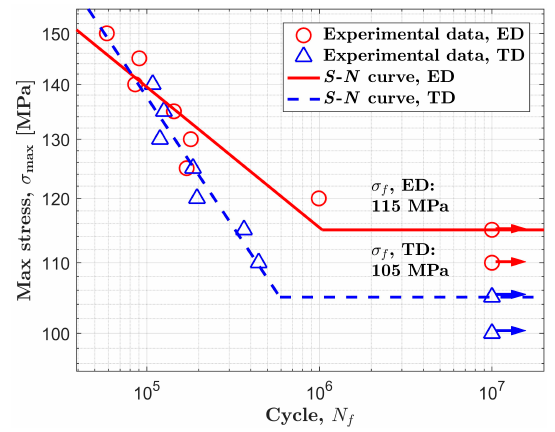
Figure 4. S – N curves of AZ31B magnesium alloy, ED and TD.